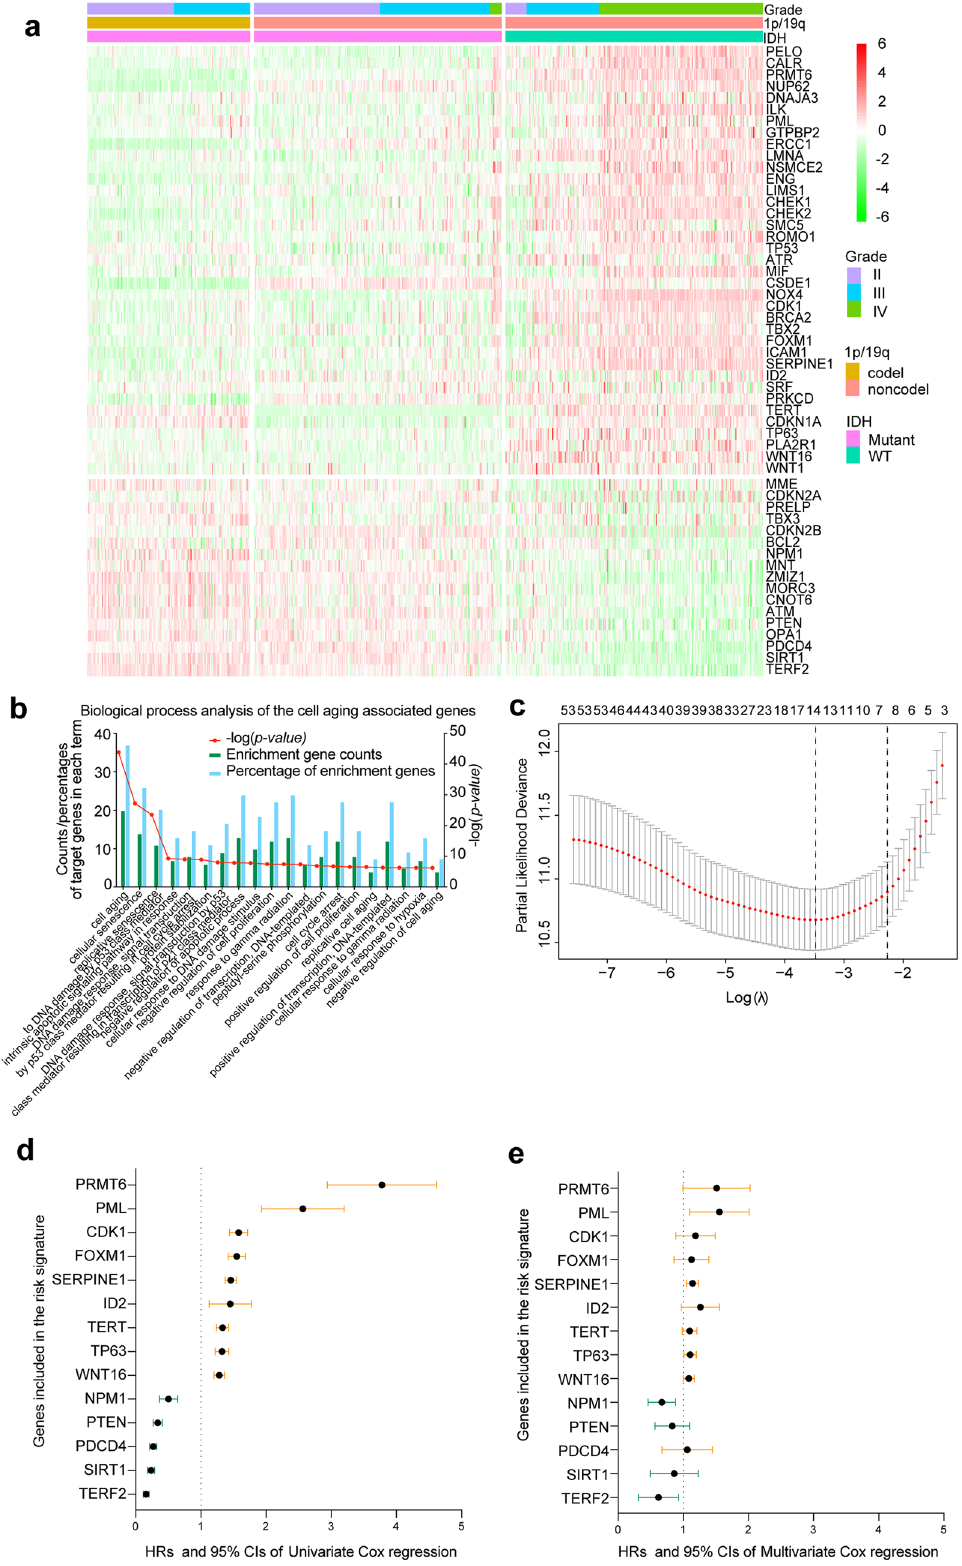
Figure 1. Prognosis-associated cell aging-related gene expression profile in gliomas. ( a ) Heatmap showing the expression pattern of the 54-cell aging-related genes associated with patient survival. ( b ) GO biological process terms enriched among the 54 survival-associated cell aging-related genes. ( c ) The 14-gene risk signature calculated by using LASSO. ( d , e ) The 14 genes included in the signature, their HRs, and 95% CIs by univariate Cox regression analysis and multivariate Cox regression